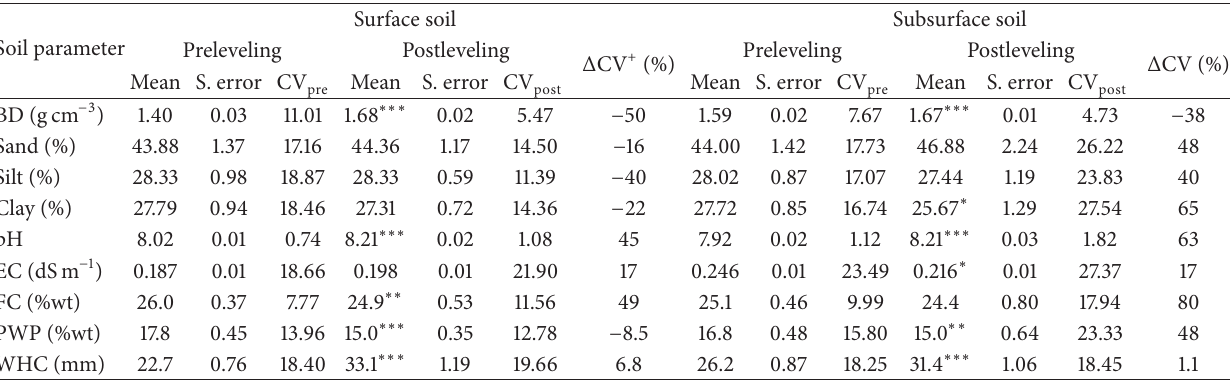
Table 1: The effect of land leveling on some selected soil properties from both 0–20 cm (surface soil) and 20–40 cm (subsurface soil). Means, standard errors, coefficients of variation, and the changes in coefficients of variation ( Δ CV) of pre- and postleveling soil properties for both surfaceandsubsurfacesoilswerereported.Asterisksnexttopostlevelingmeansrepresentsignificantdifferencesbetweenpre-andpostleveling measurements caused by land leveling. These asterisks were determined after paired t -test ( 𝑛 = 30 ).